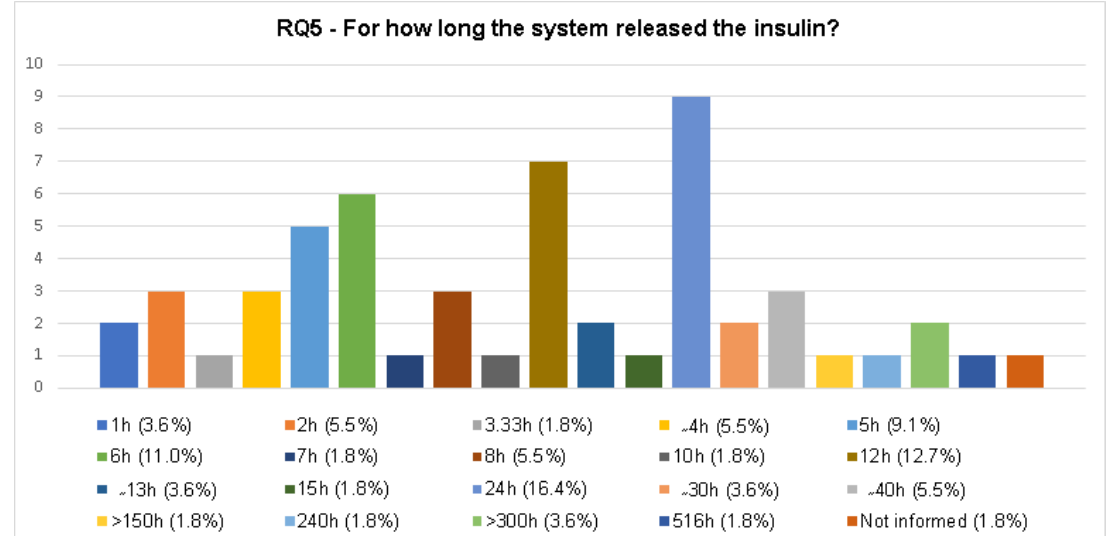
Figure 12. Categorization of the insulin release time from the chitosan / insulin release systems developed in the selected articles.